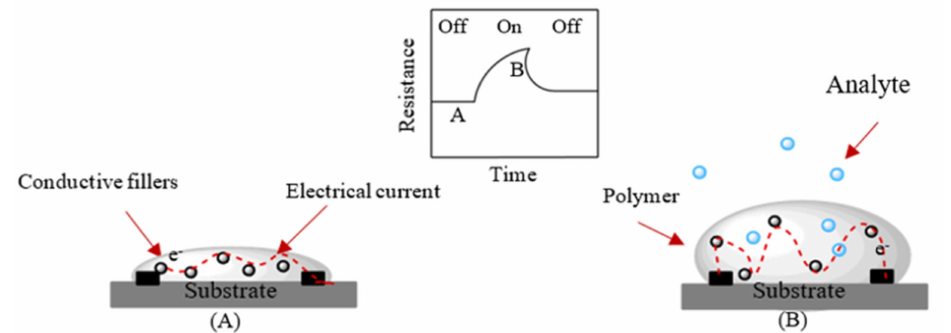
Figure 2. Schematic representation of chemiresistor mechanism based on swelling effect. The red dashed line gives the electrical current along the percolation pathway ( A ) before and ( B ) after